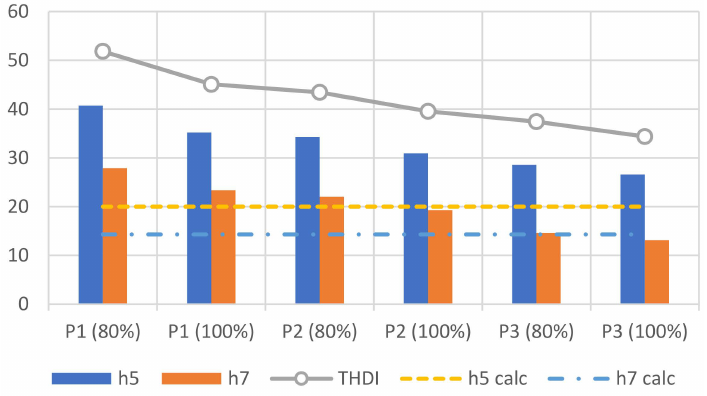
Figure 1. Harmonic current magnitudes at various equipment loading